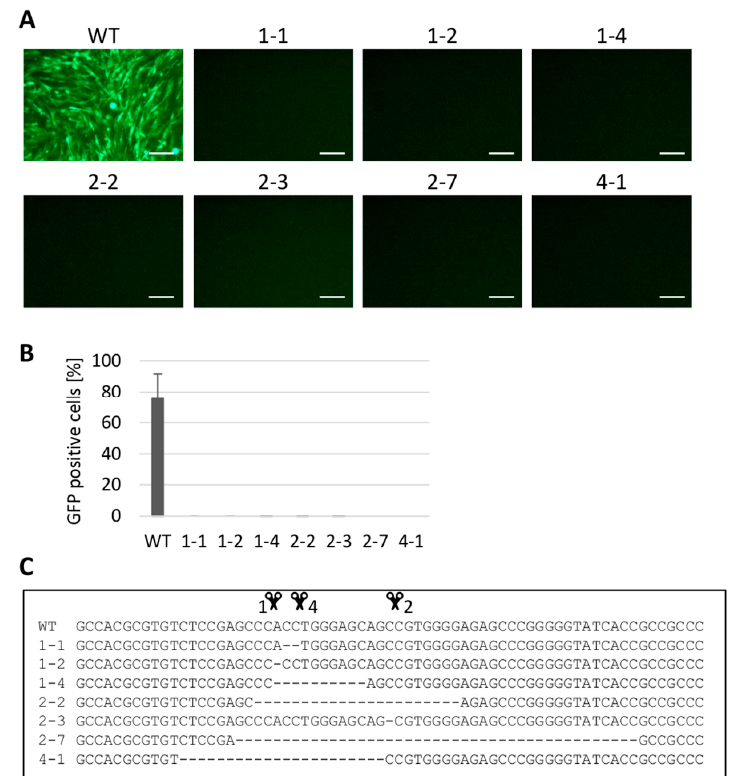
Figure 4. Analysis of chNHE1 -editied clones of DF-1 cells containing frameshifting deletions. The selected clones were challenged with the RCASBP(J)GFP reporter virus. The virus spread in the cell culture was assayed as the presence of GFP-positive cells by fluorescence microscopy ( A ) or FACS ( B ). The deletions present in both chNHE1 alleles of these clones are shown ( C ) with the cleavage points represented by the scissors. The FACS experiment was done in two parallels in two independent experiments and the results are shown as the mean ± standard errors. Scale bar = 100 μ m.